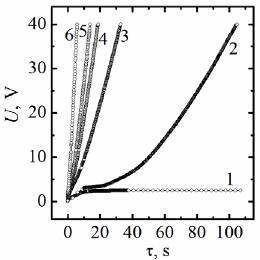
Fig. 1. Forming dependences of the Ti6Al4V alloy at j a , A